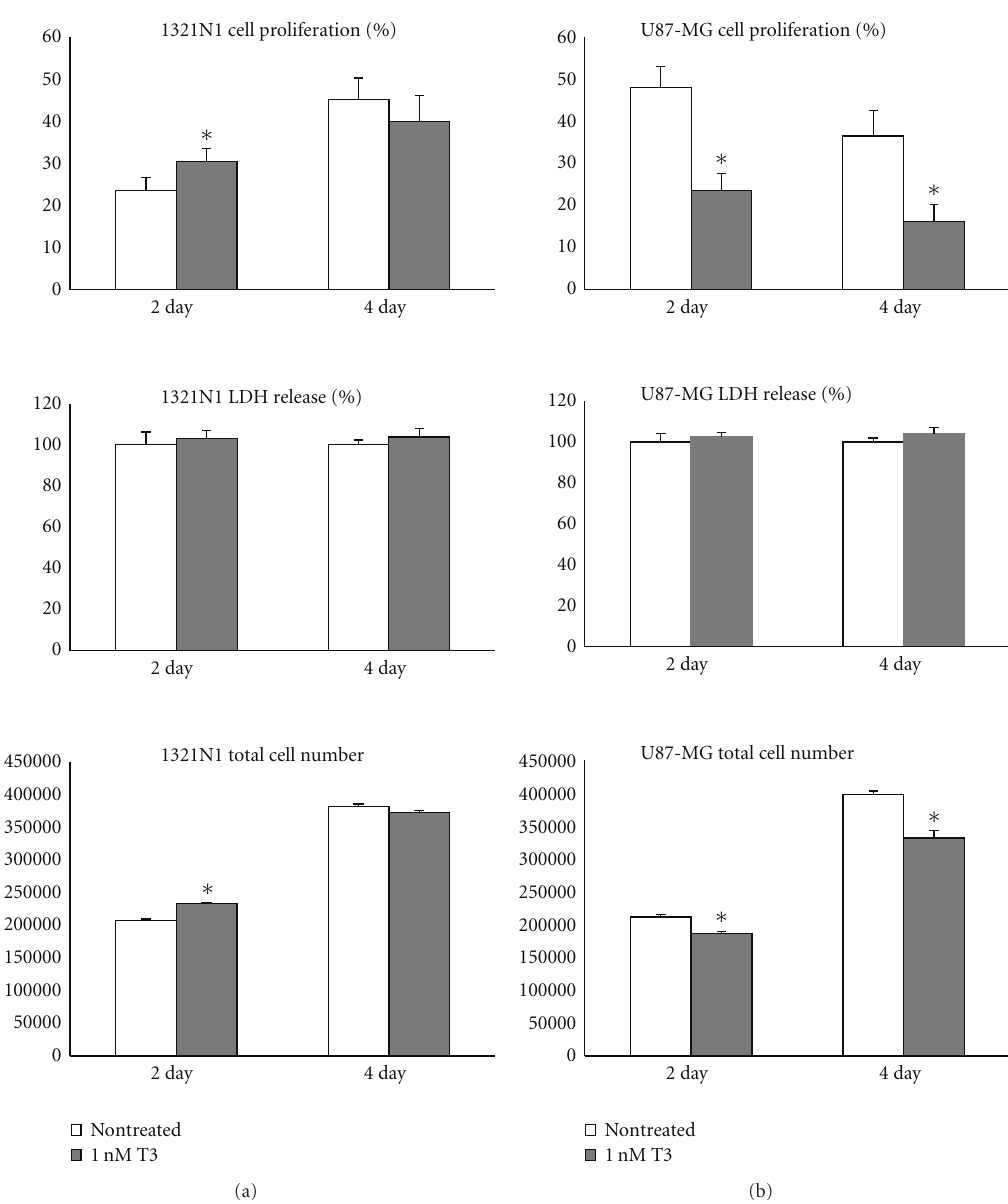
Figure 2: Cell proliferation index, LDH release, and total cell number in non-treated 1321N1 (a) and U87-MG (b) cells and after exposure to 1nM T3 medium concentration for 48 h and 96 h. Cell proliferation index was assessed as the percentage of BrdU-positive nuclei to the total number of nuclei, while LDH release was expressed in each group as percentage of the untreated group. ∗ P < 0 . 05 versus non